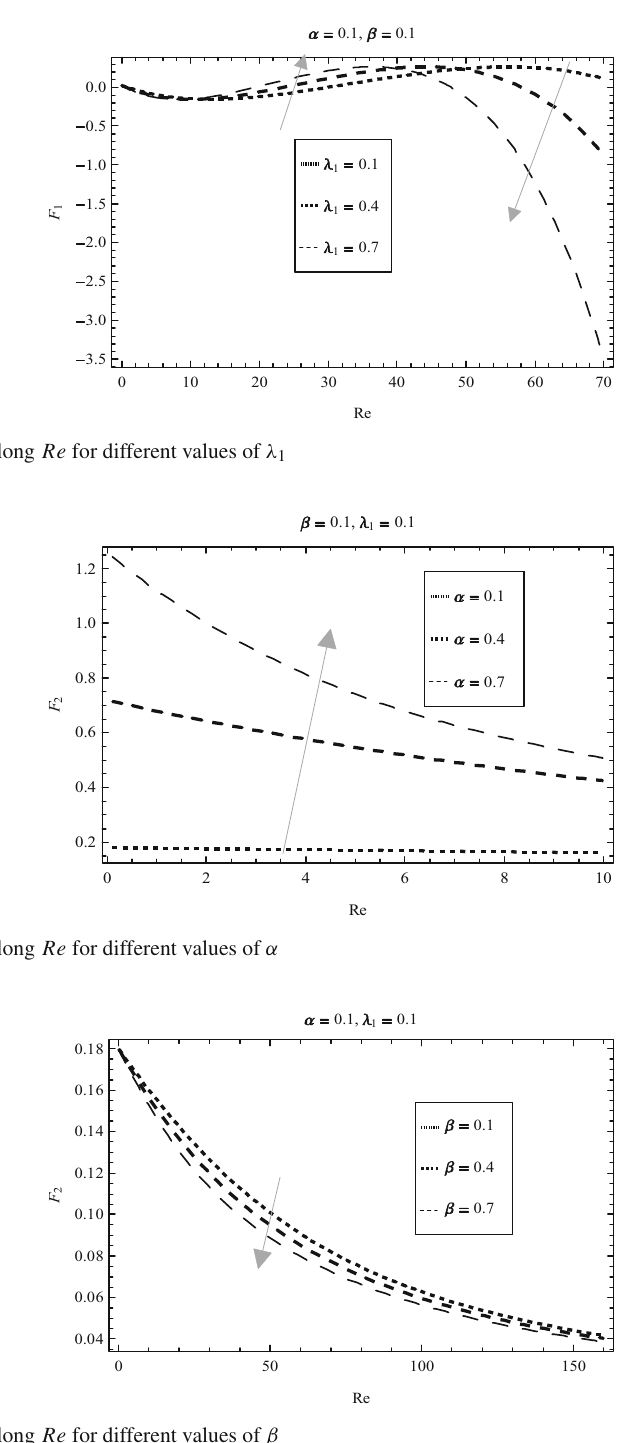
exerted by the fluid on the plate for different values of Reynolds number happens due to the dominance of inertial forces over the viscous forces (Fig. 21). Moreover, it decreases with the increase in the β and λ 1 . The reduction in the skin friction exerted by the fluid on the plate for large values of Reynolds number happens due to the dominance of viscous forces over the inertial forces (Figs. 22,